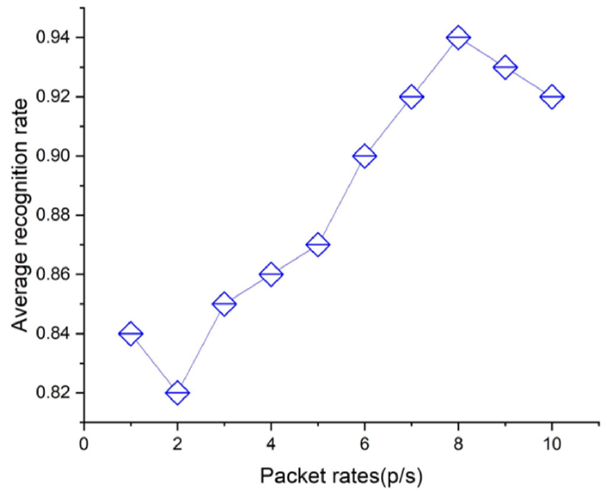
Figure 13. Influence of packet rate on recognition rate.